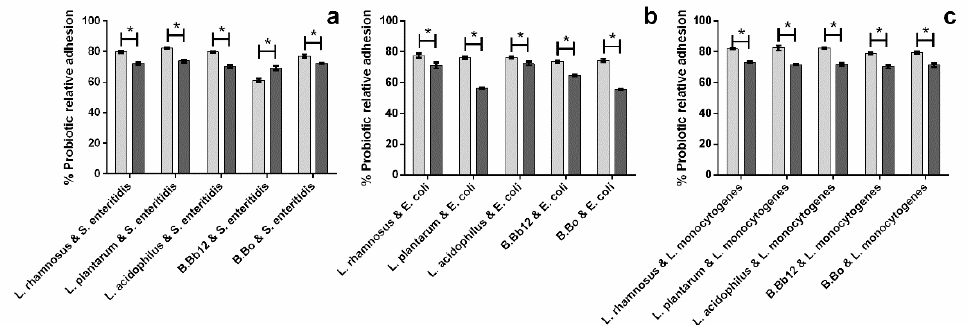
Figure 4. Impact of blueberry extract (presence ( (cid:4) ) and absence ( (cid:4) ) of extract) upon relative probiotic adhesion considering pathogen/probiotic systems. ( a ) S. enteritidis /probiotic system, ( b ) E. coli /probiotic system, and ( c ) L. monocytogenes /probiotic system. The asterisks (*) mark statistically significant differences between sets of data ( p < 0.05).